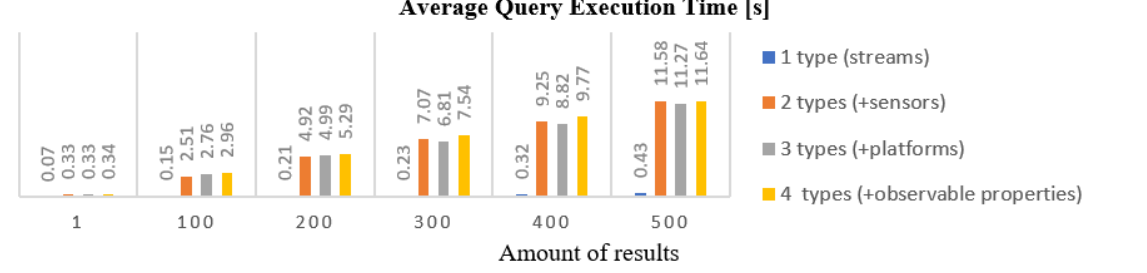
Figure 17. GraphQL query execution times.